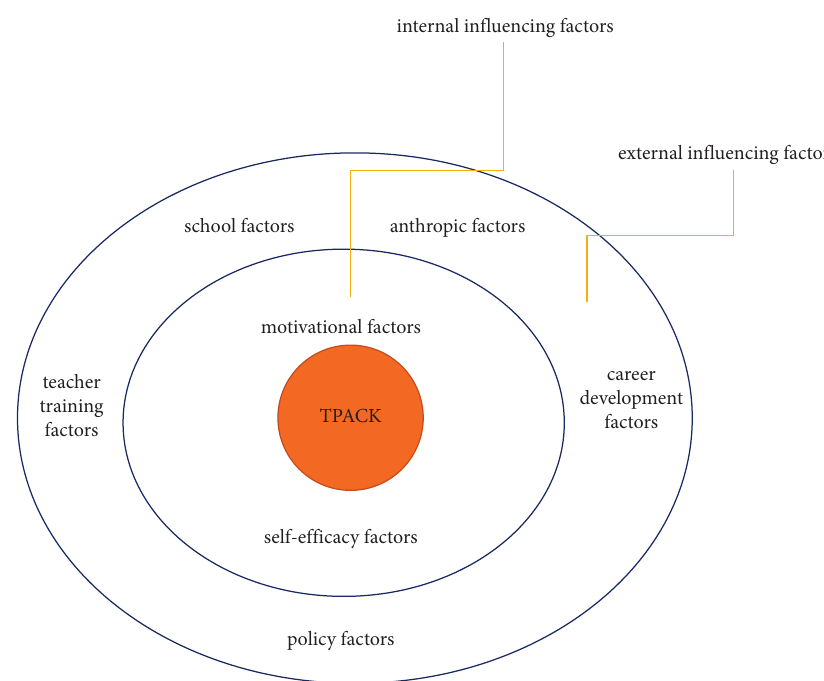
Figure 5: Influencing factors of teachers’